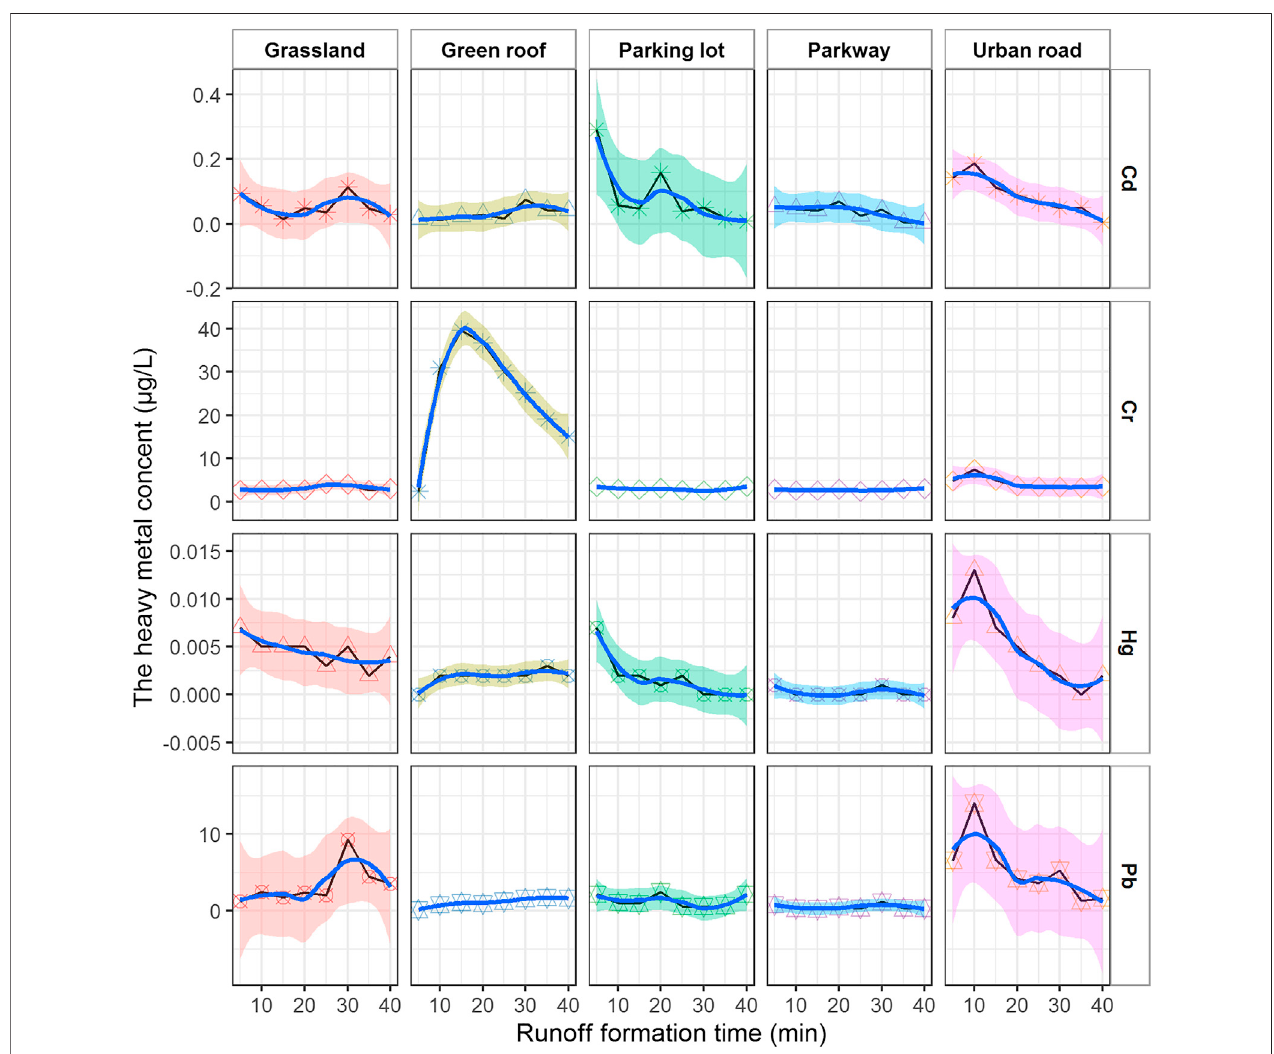
FIGURE 2 | The change in the heavy metal average concentration index over time. The smoothing blue curve was obtained by loess method, and the corresponding color shadow part was its 95% con fi dence interval.